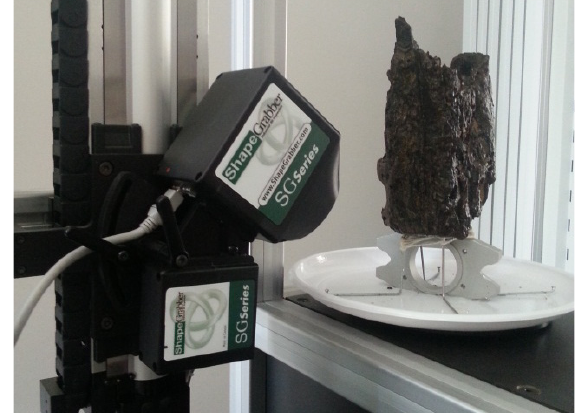
Figure 5. Test sample positioned on top of a control object and on a rotating stage to automate the 3D scan acquisition